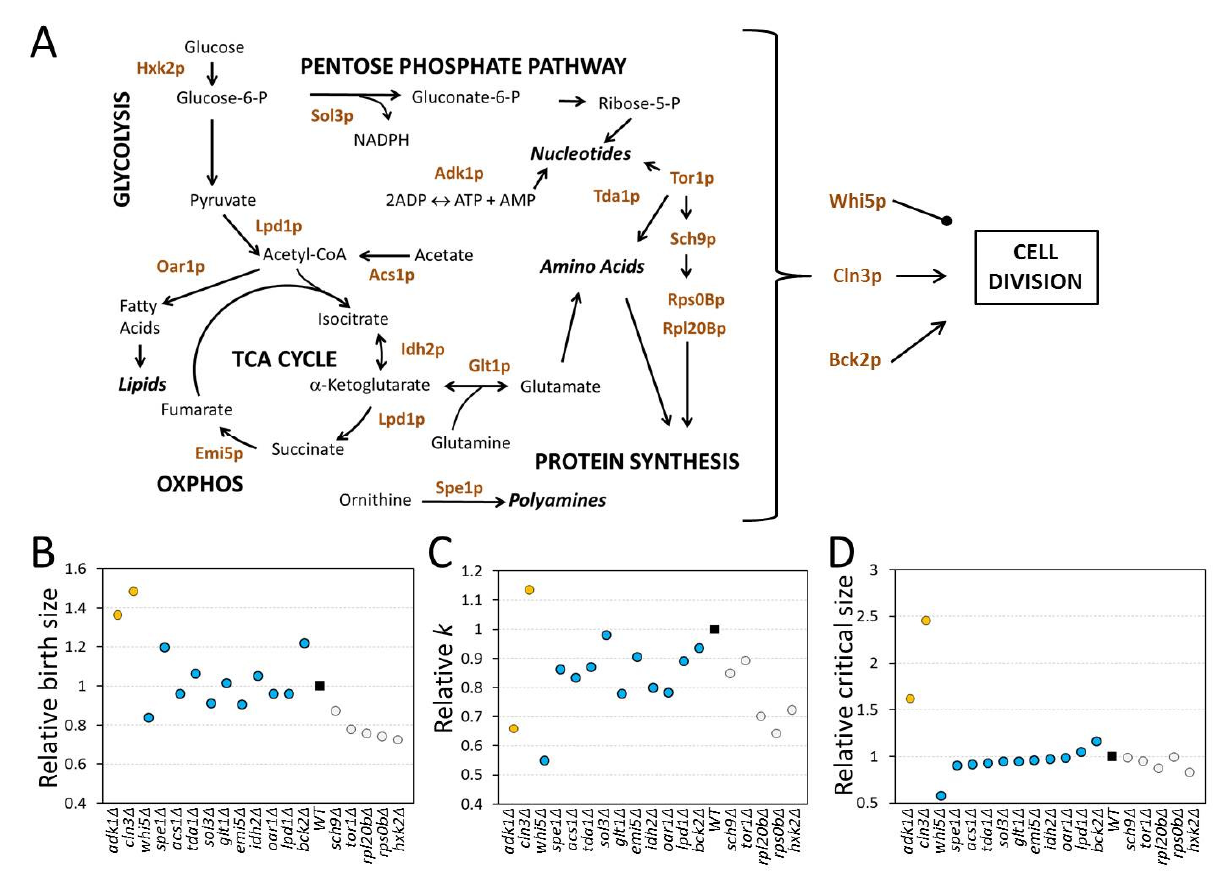
FIGURE 3: Diverse G1 phenotypes of metabolic and biosynthetic mutants. (A) Schematic overview of the reactions affected by the gene products we examined. This is a simplified view for clarity, missing numerous intervening reactions. (B) The birth size of each mutant shown on the x-axis was calculated for each deletion strain in the BY4741 and Y7092 background, shown in Table 2. For each gene deletion, the values from the two strain backgrounds were averaged, expressed relative to the corresponding value of the wild type, and shown on the y- axis. The gene deletions were group in three groups, based on principal component analysis and k -means clustering, using the R open source software, from the data shown in Table 2. The filled square is the wild type value. The relative specific rate of size increase (C) and critical size (D) are shown for each gene deletion, calculated and displayed as in (B), from the data shown in Table